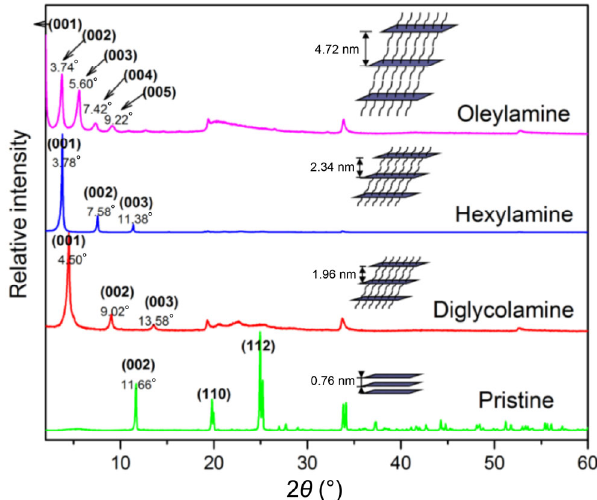
Fig. 5 XRD patterns of pristine  -ZrP nanosheets and  -ZrP nanosheets intercalated by diglycolamine, hexylamine, and oleylamine, respectively. Insets: schematics illustrating the intercalated structures and lattice